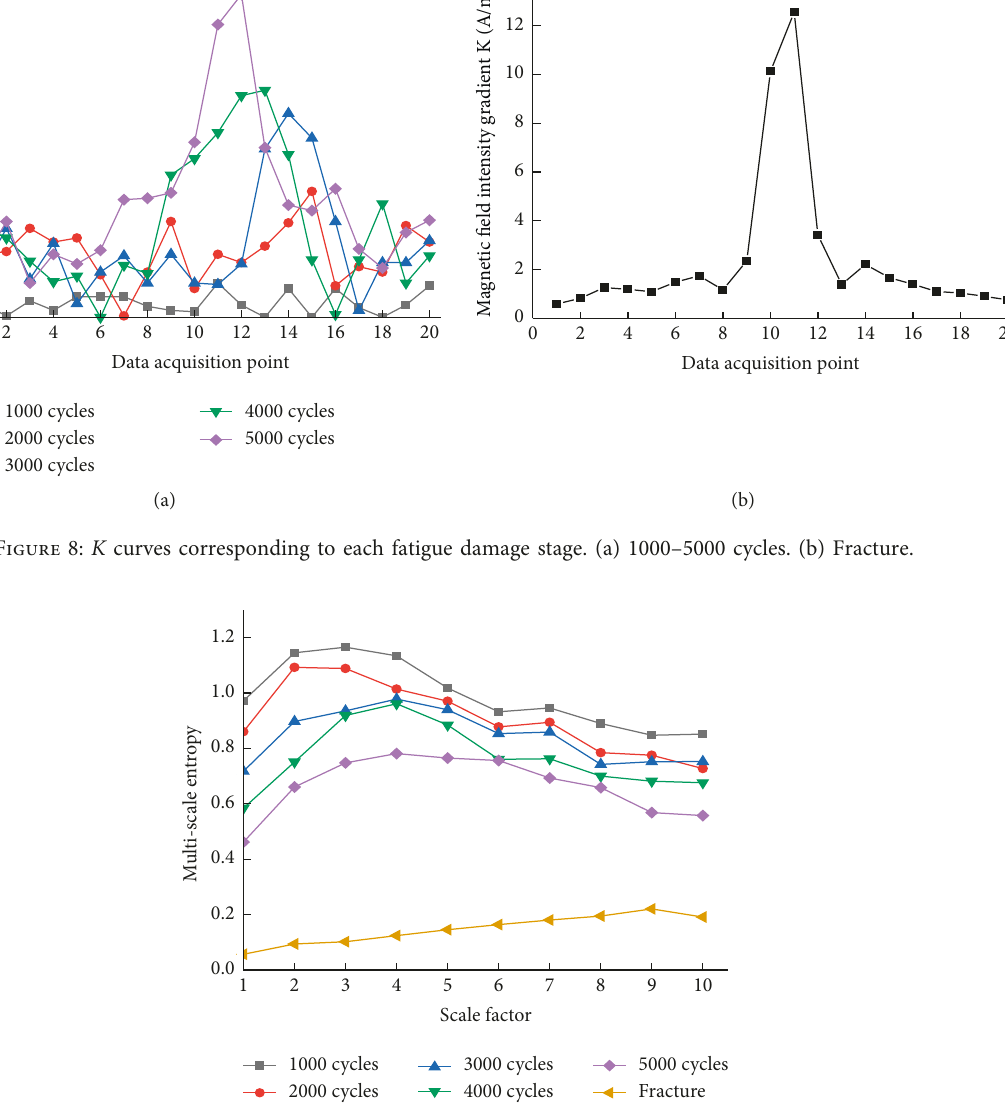
Figure 9: Variation curves of K multi-scale entropy.